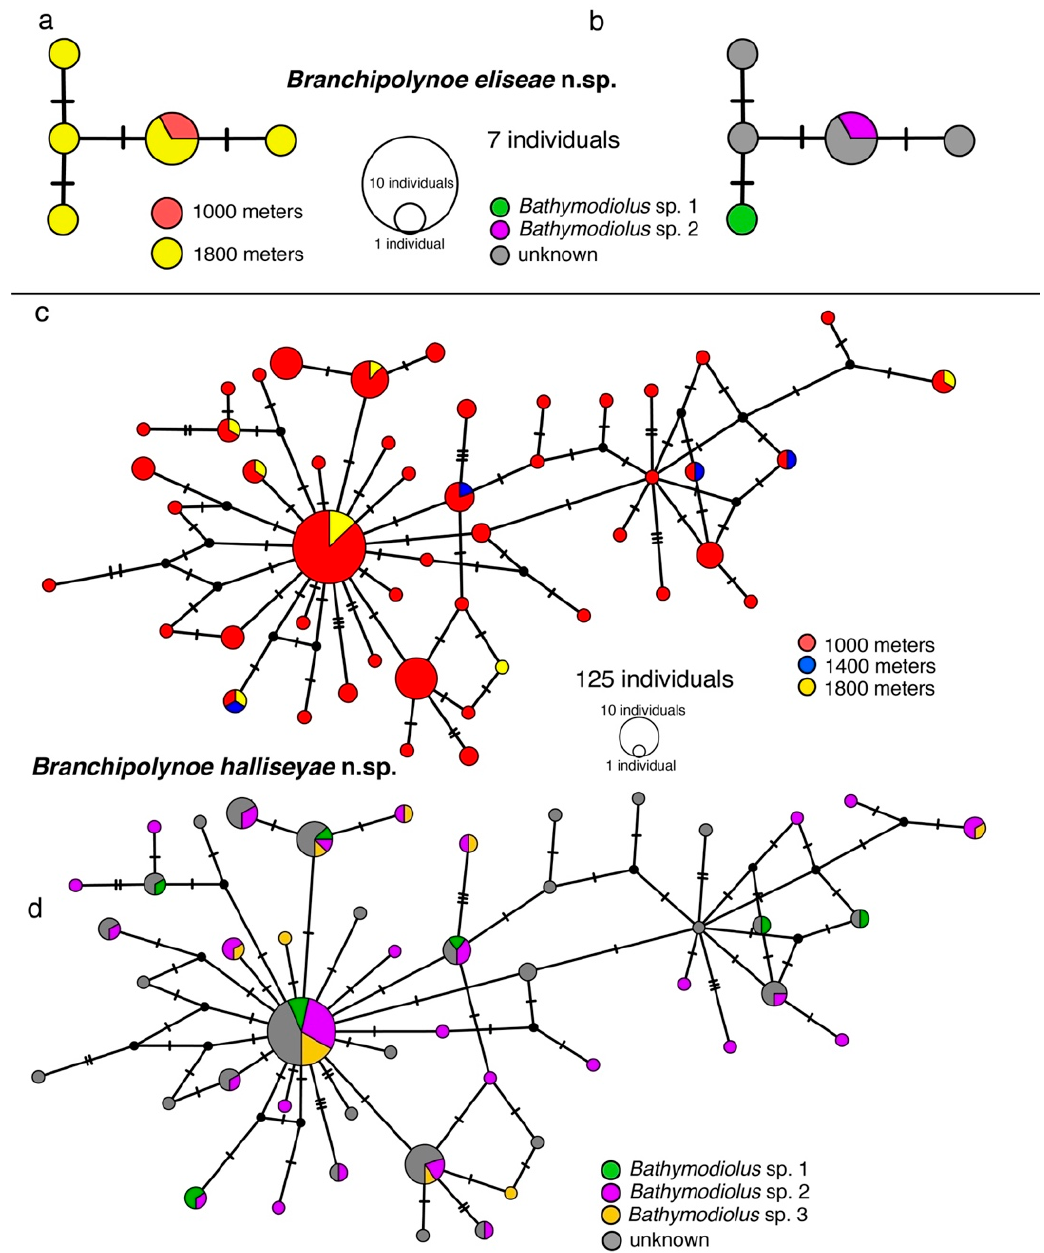
Figure 4. ( a ) COI haplotype network for 7 individuals of Branchipolynoe eliseae n. sp. with depth coding. ( b ) COI haplotype network for 7 individuals of Branchipolynoe eliseae n. sp. with host coding (where known). ( c ) COI haplotype network for 125 individuals of Branchipolynoe halliseyae n. sp. with depth coding. ( d ) COI haplotype network for 125 individuals of Branchipolynoe halliseyae n. sp. with host coding. Many hosts were unknown owing to the worms being found outside the shells.